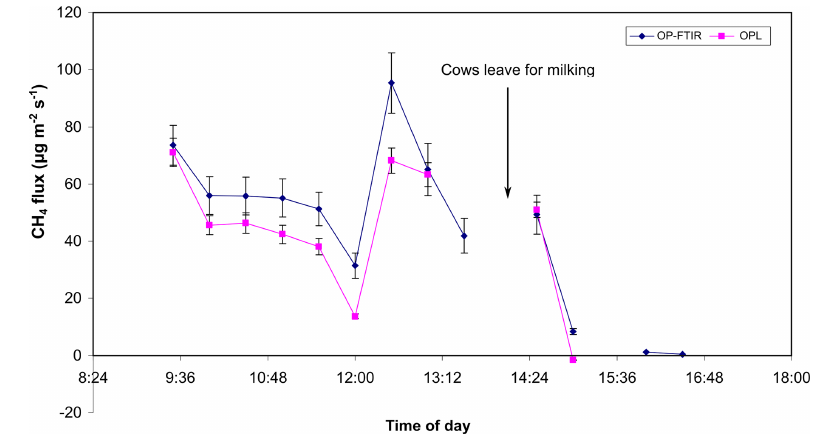
Figure A6. CH 4 fluxes determined from OP-FTIR and OPL (1012) data and the bLs model at Kyabram on 21 March 2006.